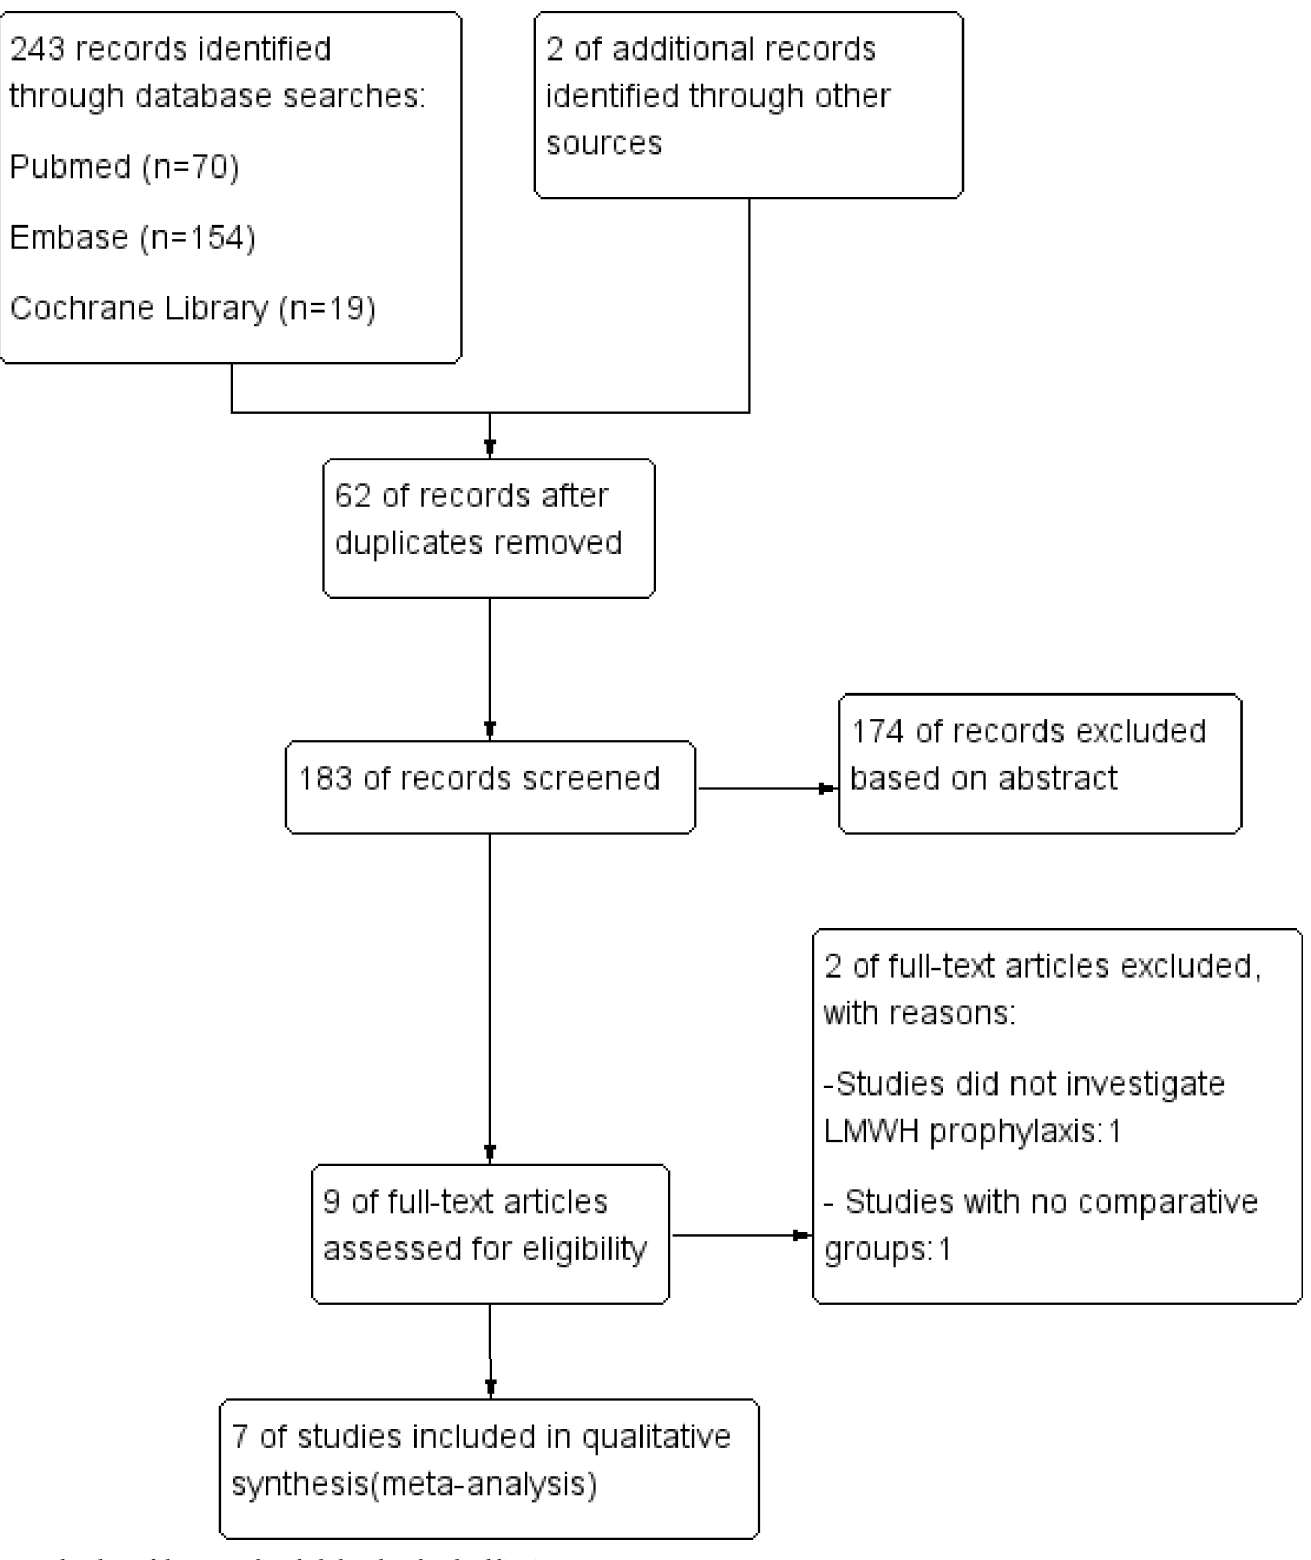
Fig 1. Flowchart of the screened, excluded, and analysed publications.